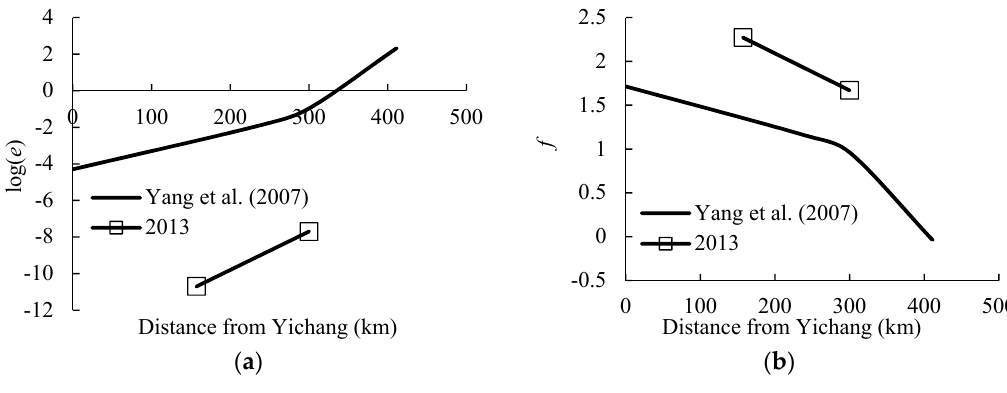
Figure 8. Coefficients and exponents of sediment rating curves ( a ) for log( e ) and ( b ) for f ; solid lines are data drawn from Yang et al. [39].